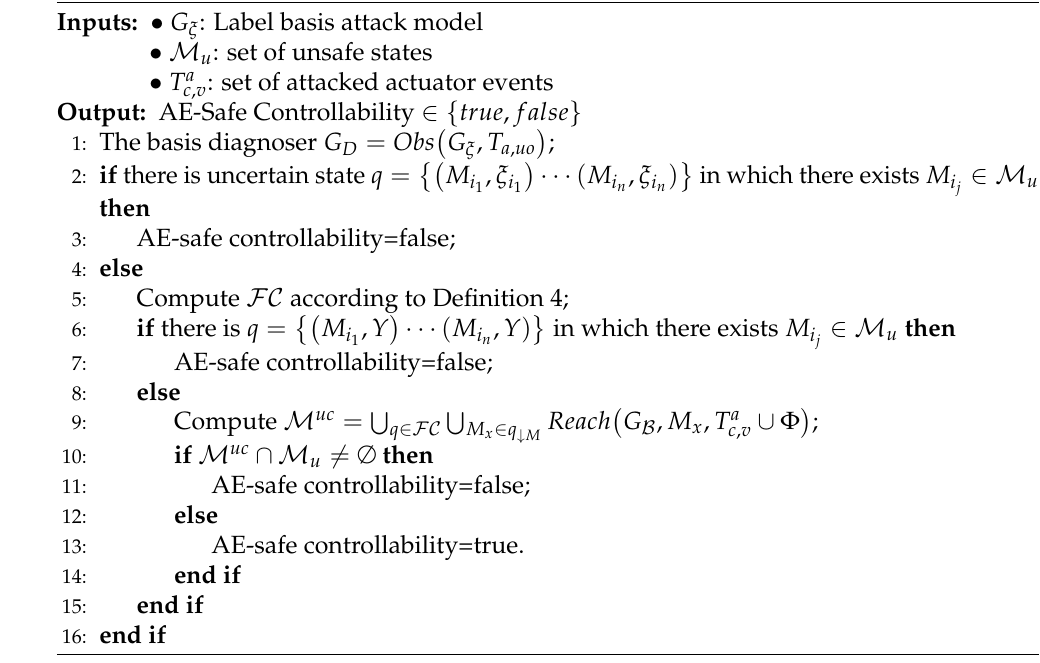
Algorithm 4 AE-safe controllability test using basis